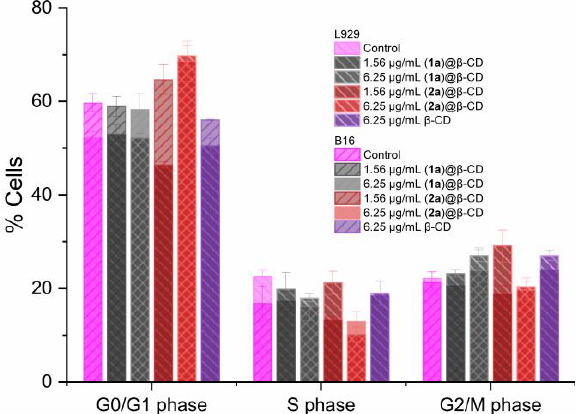
Figure 13. Cell cycle distribution of L929 and B16 cells treated with ( 1a )@ β -CD, ( 2a )@ β -CD and β -CD for 24 h at 1.56 and/or 6.25 µg/mL concentrations ( p values are based on ANOVA analysis with Dunnett’s mu ltiple comparisons post-test versus control condition).